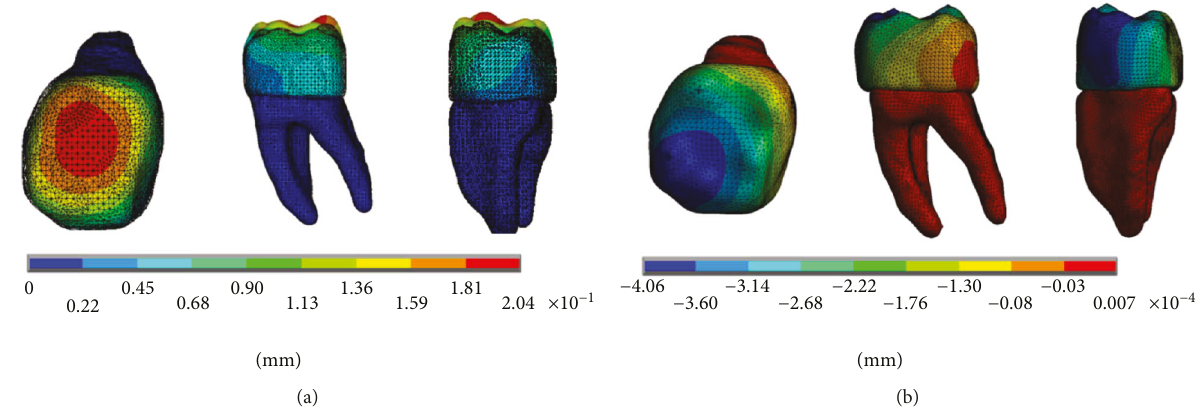
Figure 12: Displacements in the z -axis. (a) Noncontact. (b) Contact.